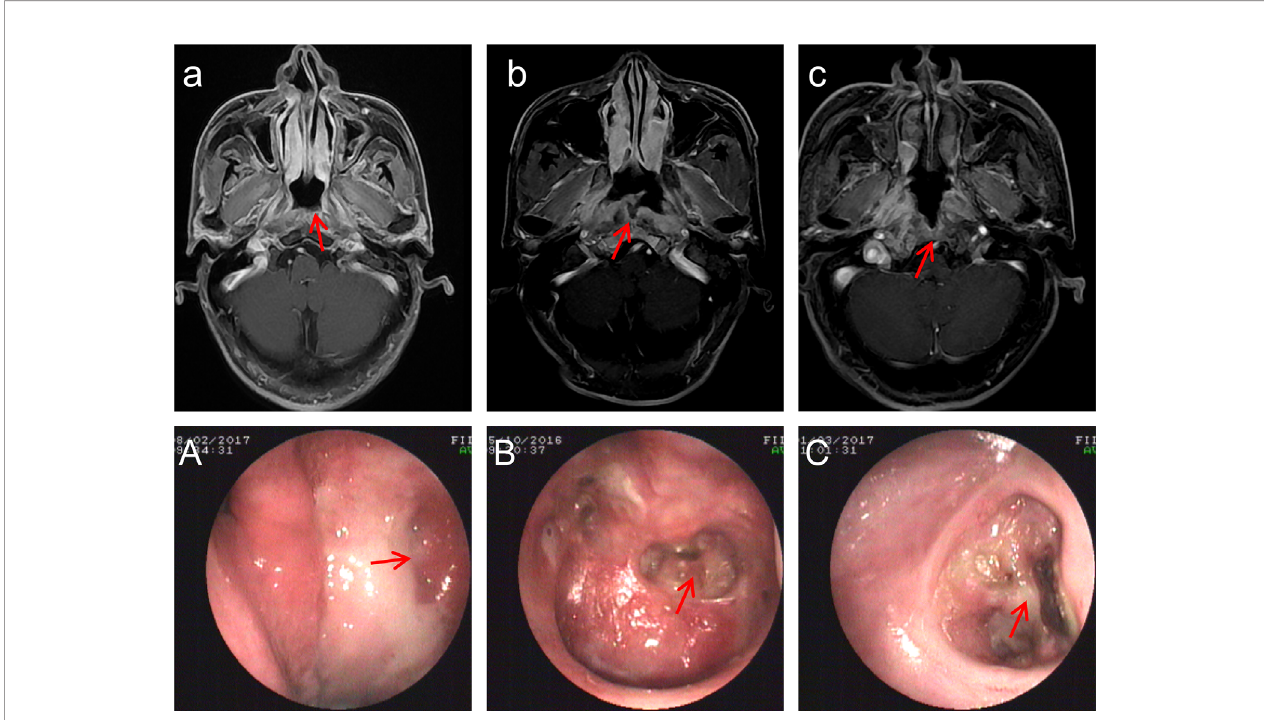
FIGURE 1 | MRI and endoscopic images with post-radiation nasopharyngeal necrosis (PRNN). (a) Transverse, contrast-enhanced T1-weighted magnetic resonance imaging (MRI) of mild-grade PRNN shows discontinuous nasopharyngeal mucosa lines. (A) Endoscopic image with mild-grade PRNN. (b) Transverse, contrast- enhanced T1-weighted MRI of moderate-grade PRNN shows discontinuous mucosa lines and non-enhanced areas. (B) Endoscopic image with moderate-grade PRNN shows a super fi cial ulcer. (c) Transverse, contrast-enhanced T1-weighted MRI of severe-grade PRNN shows invasion of the skull base bone. (C) Endoscopic images with moderate-grade PRNN show a deep ulcer. The red arrow points to the